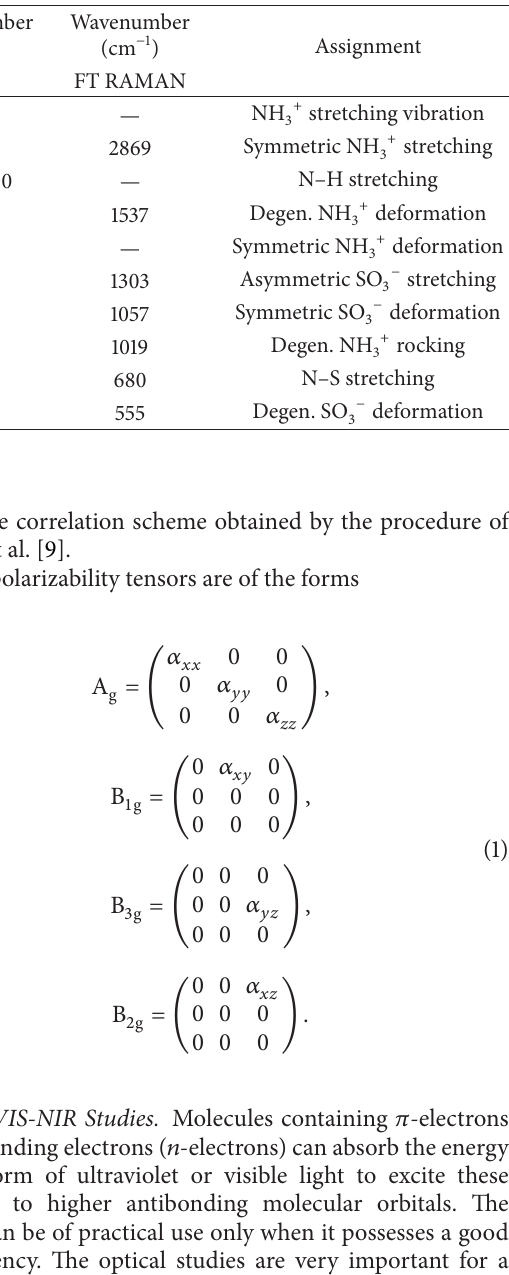
Table 2: Vibrational assignments.